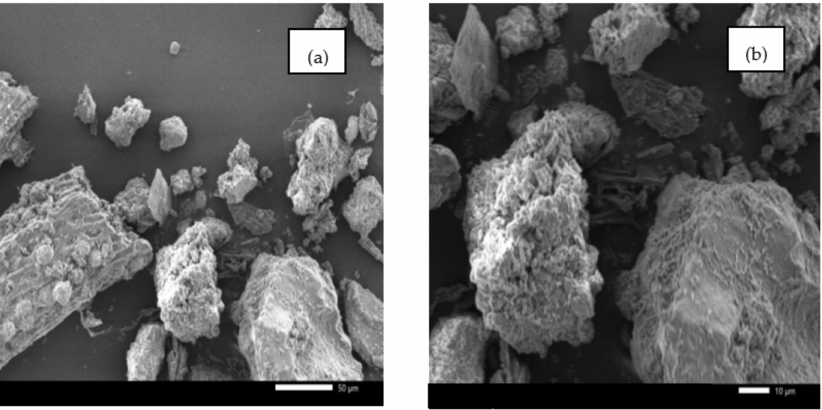
Figure 1. SEM analysis results of BCR: ( a ) × 500 and ( b ) × 1000 magnification.